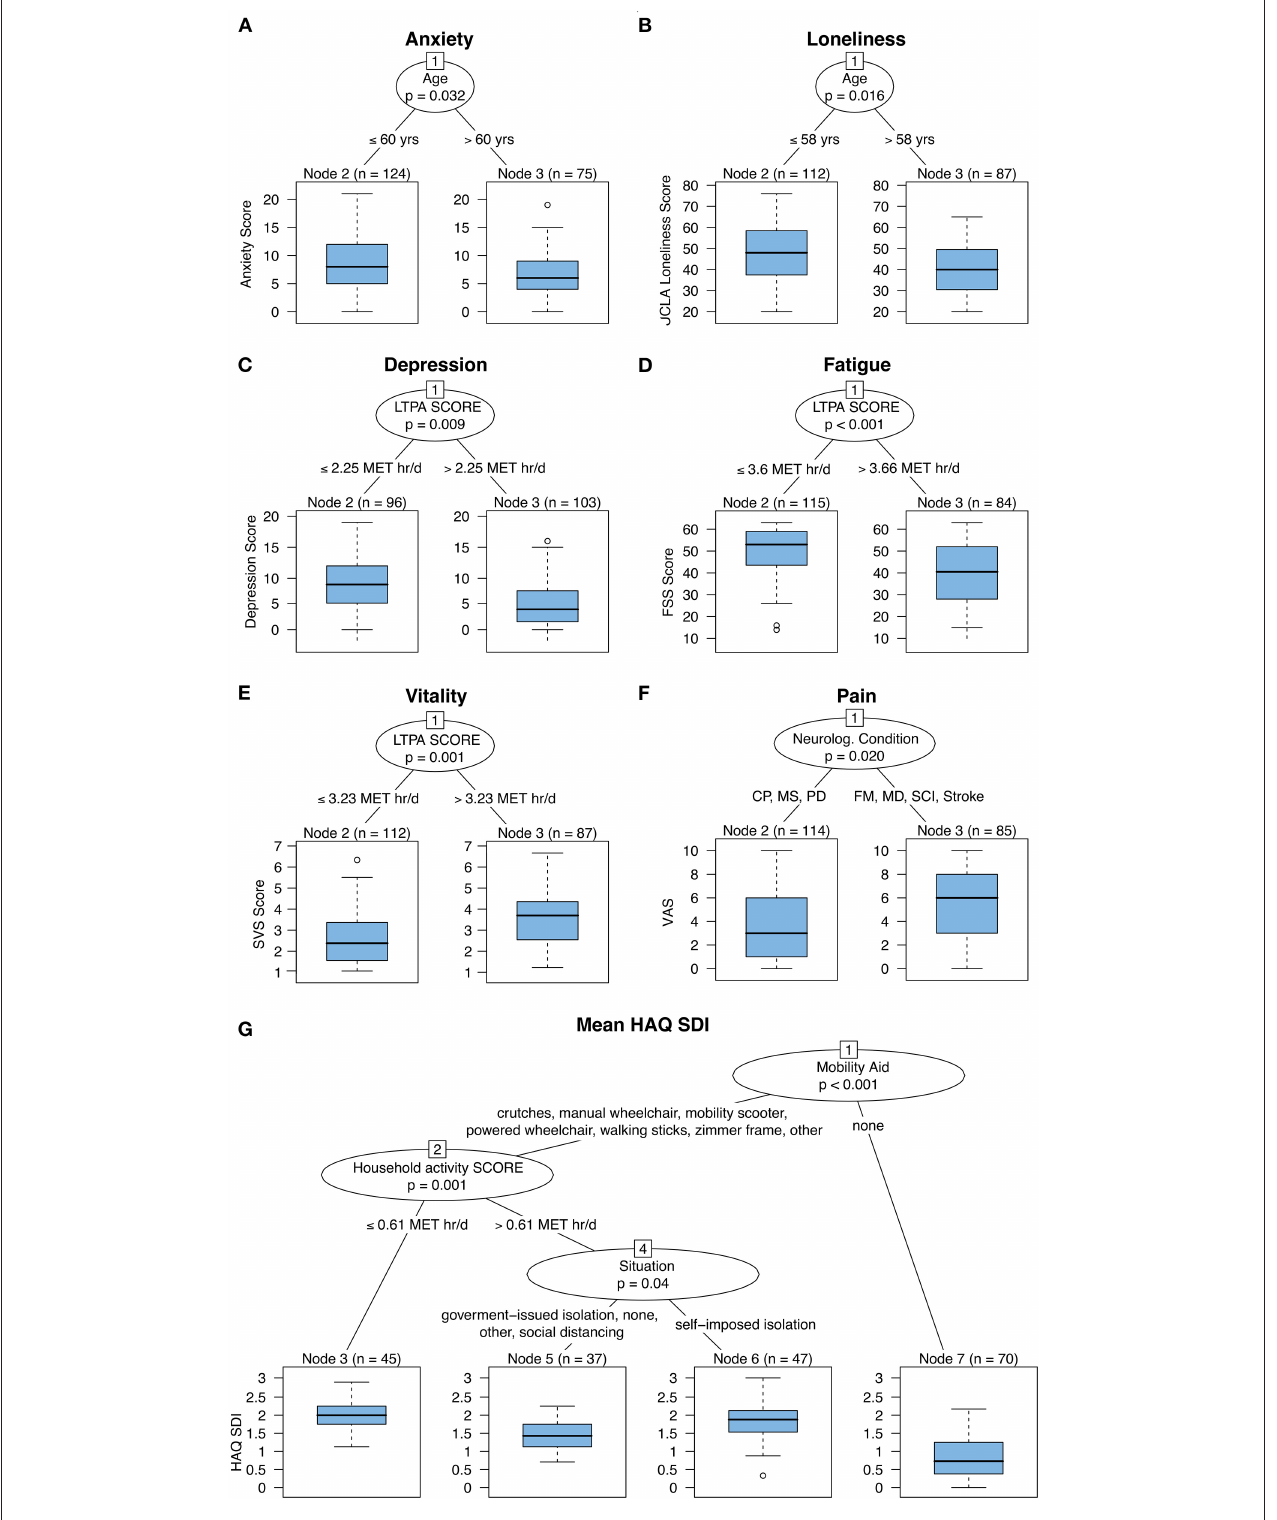
FIGURE 2 | Unbiased recursive partitioning with conditional inference tree (URP-CTREE) for anxiety (A) , loneliness (B) , depression (C) , fatigue (D) , vitality (E) , pain (F) , and HAQ SDI (G) . The initial cohort comprises 199 participants with neurologically-related mobility disabilities. Across outcomes, LTPA score and age